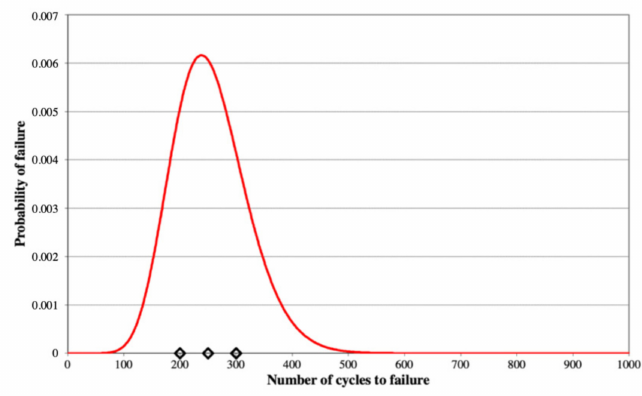
Figure 16. Damage localization for di ff erent kind of meshes.